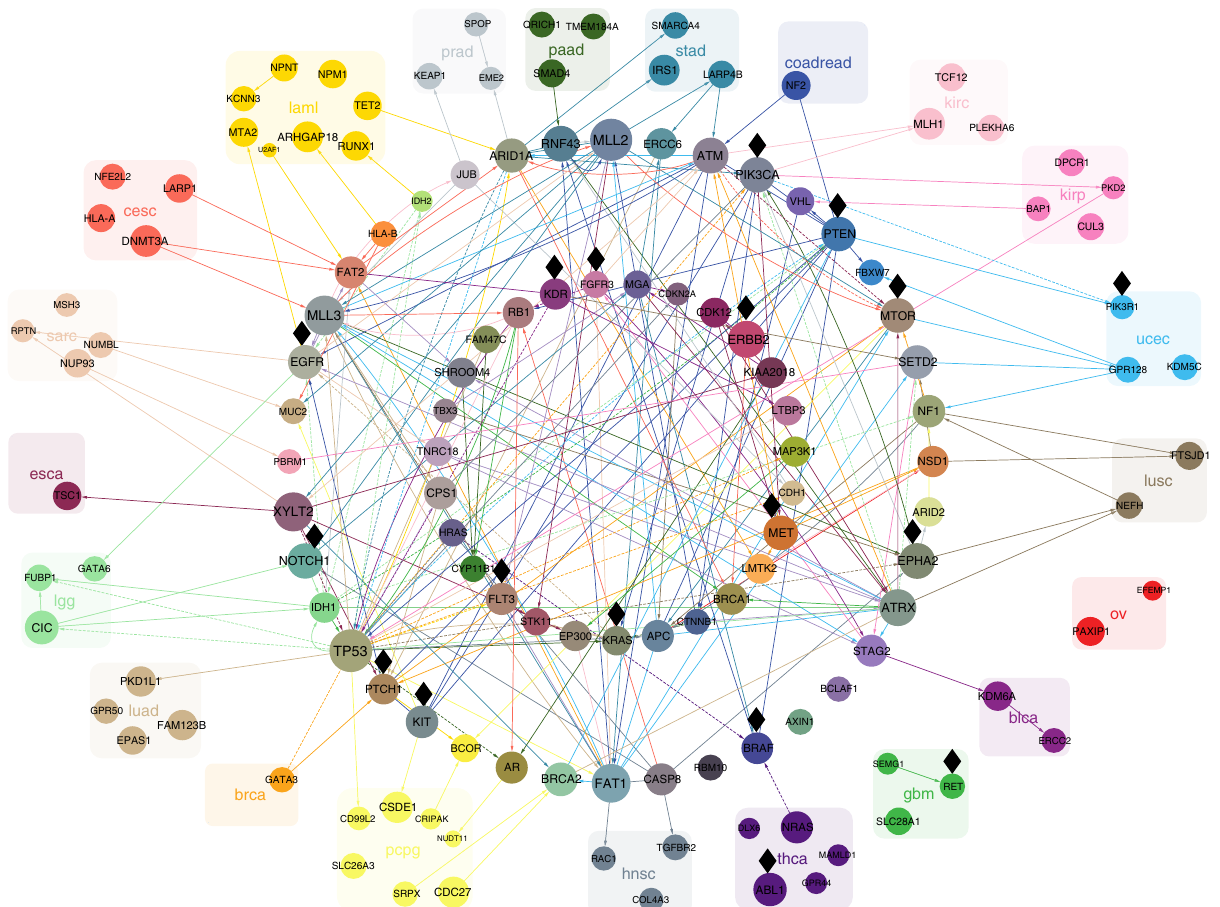
Fig. 2 The cancer-speci fi c connections between the genes. For clarity we limit the display to only include connections between the 20 most frequent and connected mutations per cancer type. The Bayesian networks for each cancer type are overlaid on the same union of gene nodes. Edges highlight interactions between the selected mutations and are coloured by the cancer type for which they occur (leukaemia: yellow; glioblastoma: green, etc.). Directed edges point in the inferred direction of dependency, whereas undirected edges indicate cases where the direction cannot be inferred. Solid edges indicate positive correlation (a degree of co-occurrence) while dashed edges indicate negative correlation (a degree of exclusivity) between the genes connected. Genes are coloured according to the colours of their edges. Those with edges in only one speci fi c cancer type are grouped and labelled with the same colour. Genes with edges in different cancer types are arranged in the two circles in the centre. The size of each gene correlates with the total number of edges across all cancer types, including edges that are not shown. Black diamonds mark putatively actionable